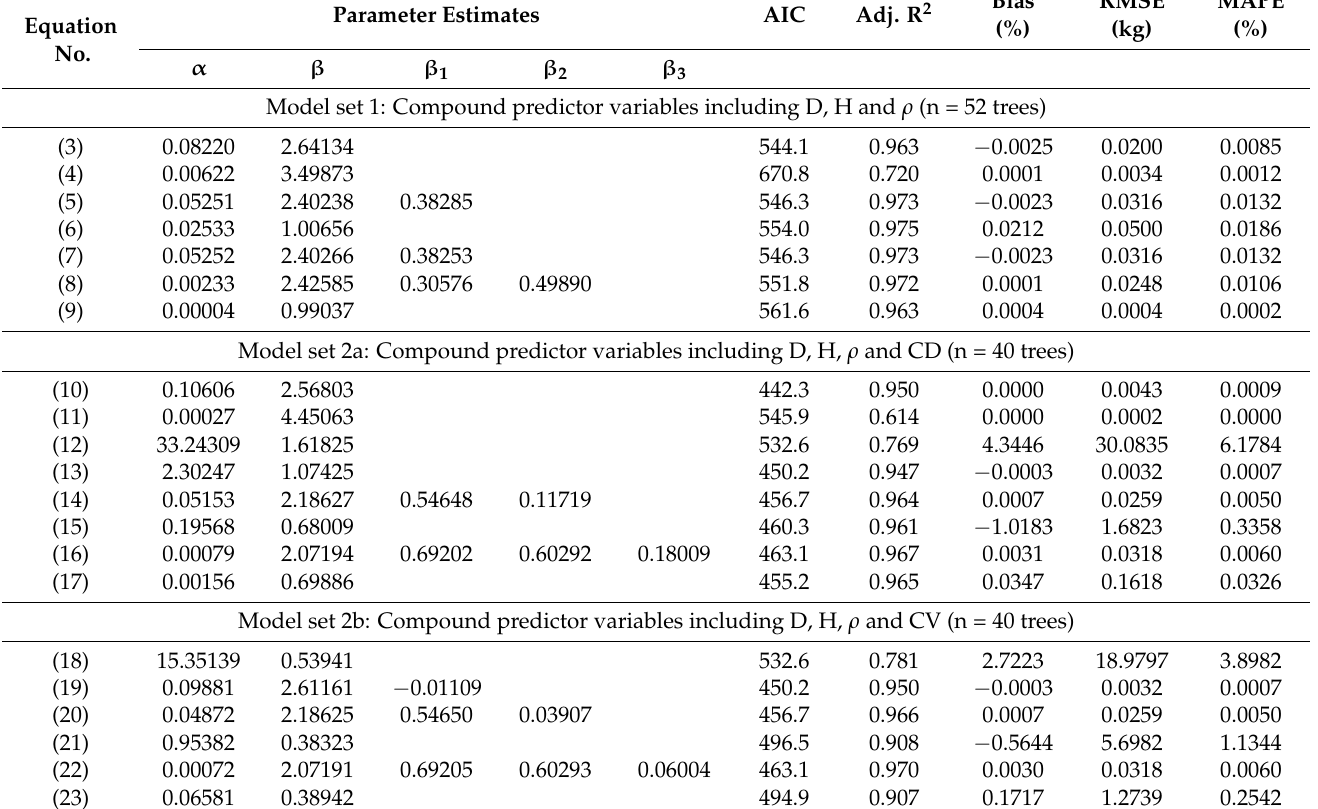
Table 4. Parameter estimates and their standard errors for AGB models developed based on weighted nonlinear models: D is diameter at breast height (cm), H is total tree height (m), AIC is Akaike Information Criterion, bias is averaged bias (%), RMSE is averaged root mean square error (kg), MAPE is averaged mean absolute percent error (%). Each equation number here refers to those